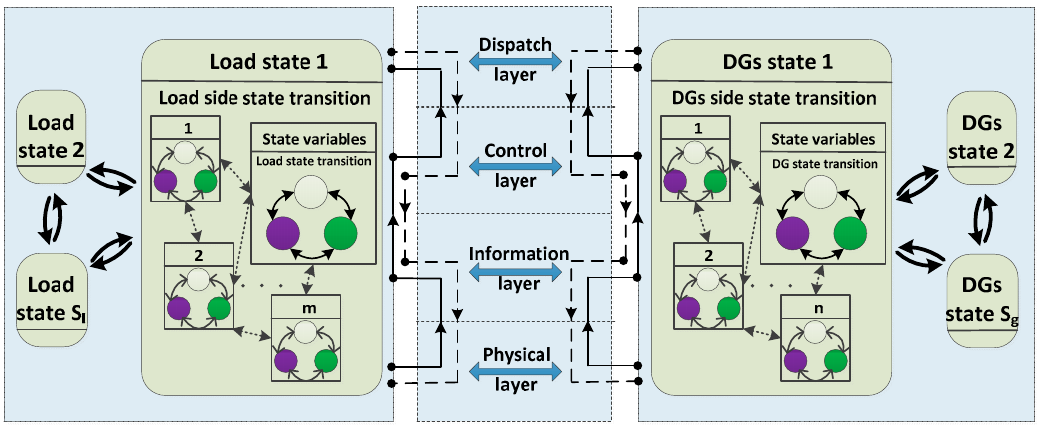
Figure 5. State transition model of microgrid-enabled intelligent building.